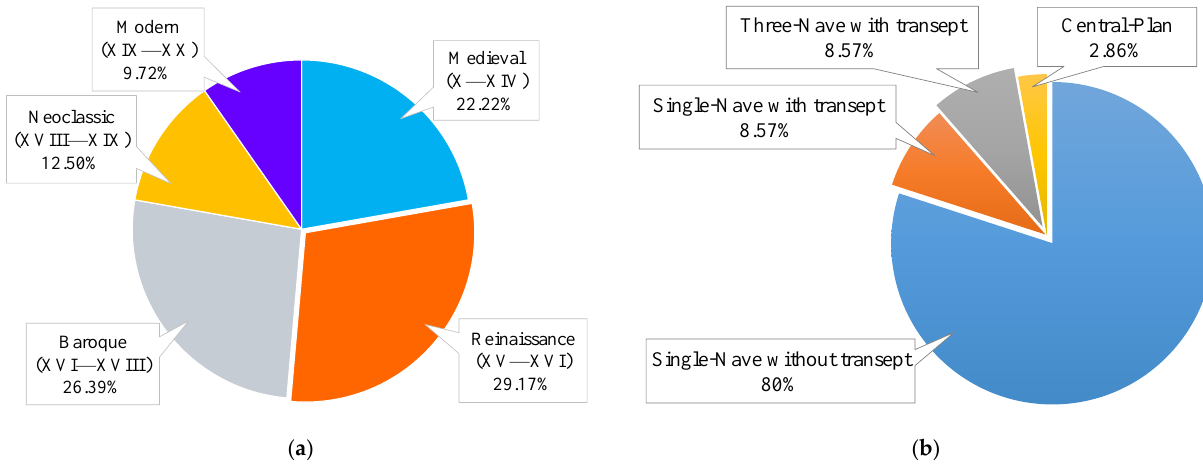
Figure 3. Foundation period of the surveyed churches ( a ) and architectural features ( b ).